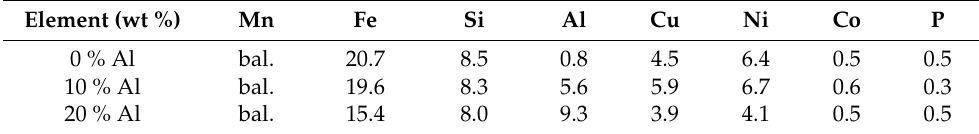
Table 2. The average composition of experimental Mn-based alloys (XRF). Element (wt